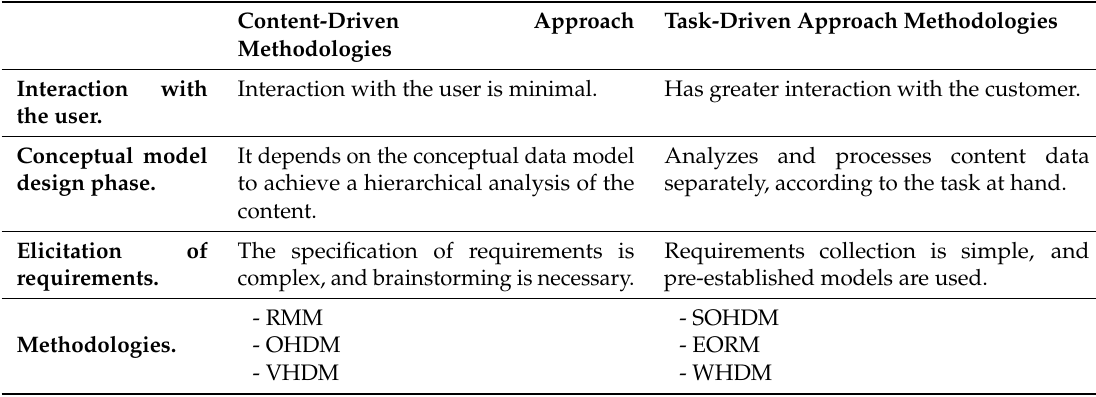
Table 7. Hypermedia developmental characteristics analysis considered in primary